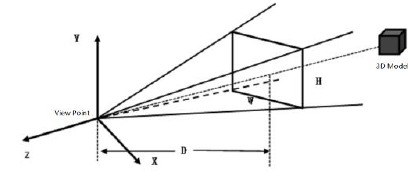
Figure 2. Camera system of OpenGL. W, H is the width and height of 3d depth image. D is the distance of view point to culling plane.